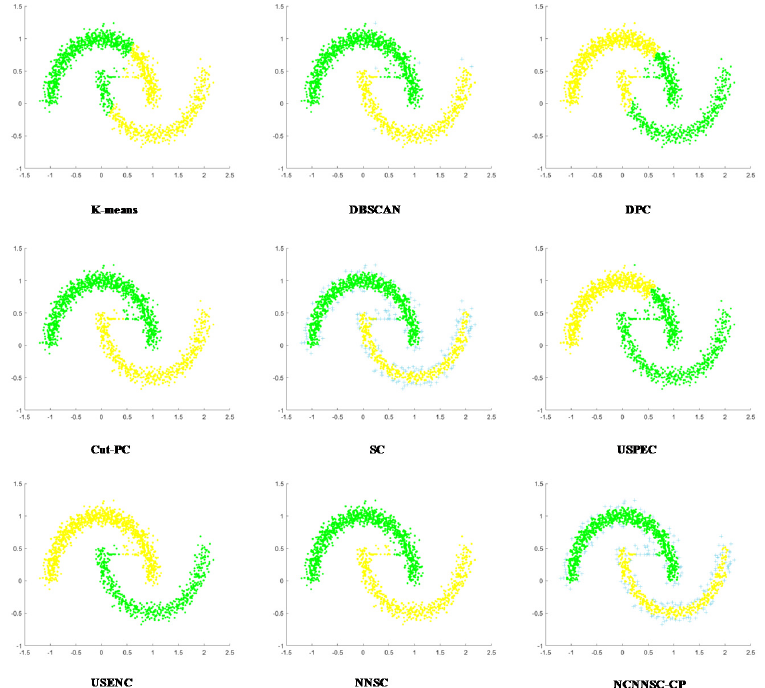
Figure 8. The results of 9 clustering algorithms in D3.